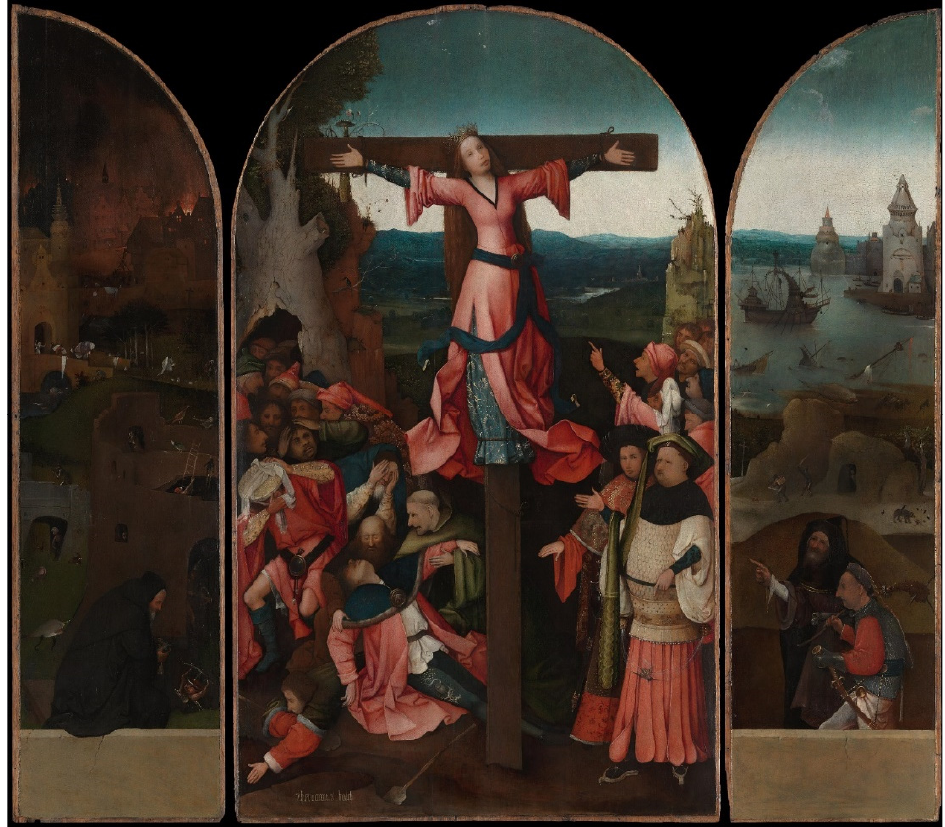
Figure 1. Saint Wilgefortis Triptych (c. 1497) by Hieronymus Bosch. Photo Credit: http://boschproject.org, Public Domain, https://commons.wikimedia.org/w/index.php?curid=2634019 (accessed on 29 May 2022).